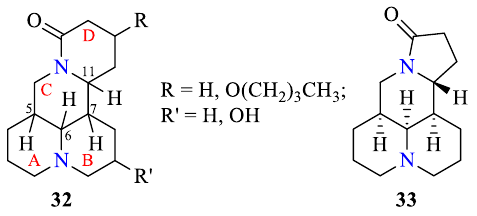
Figure 1. Matrine type alkaloids.